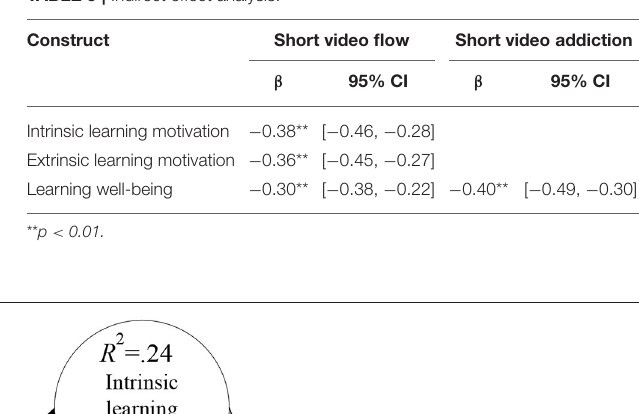
TABLE 5 | Indirect effect analysis.